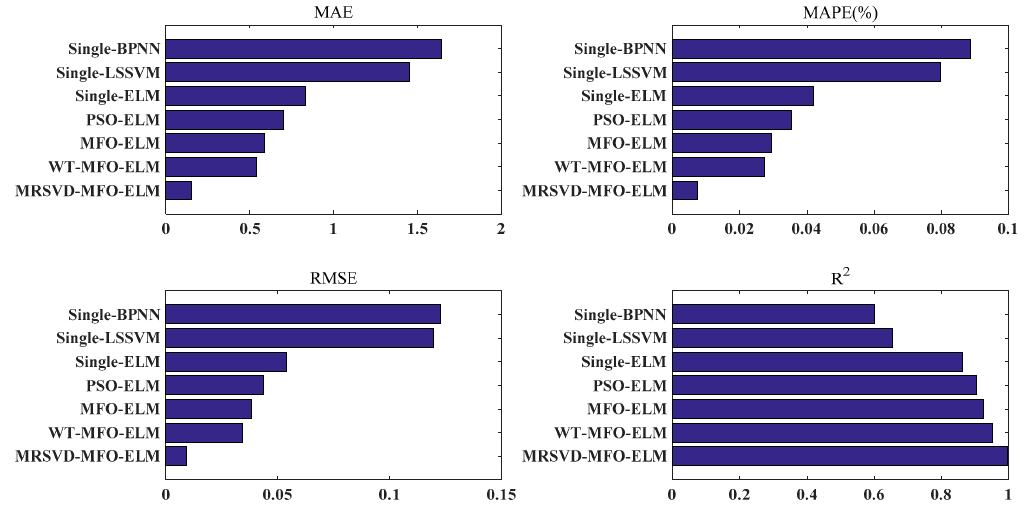
Figure 13. Evaluation criteria values of seven models for EUA spot price forecasting.